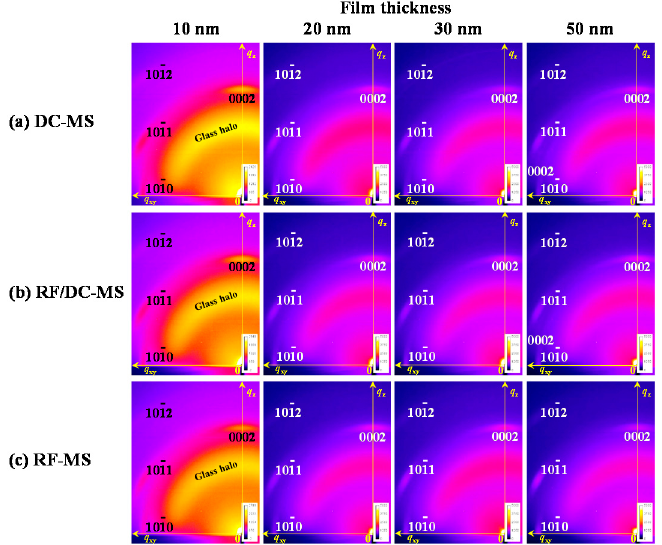
Figure 3. Two-dimensional diffraction images of Al-doped ZnO (AZO) films with film thicknesses of 10, 20, 30, and 50 nm deposited by ( a ) DC magnetron sputtering (DC–MS), ( b ) RF/DC magnetron sputtering (RF/DC–MS) at a power ratio of 0.14, and by ( c ) RF magnetron sputtering (RF–MS).